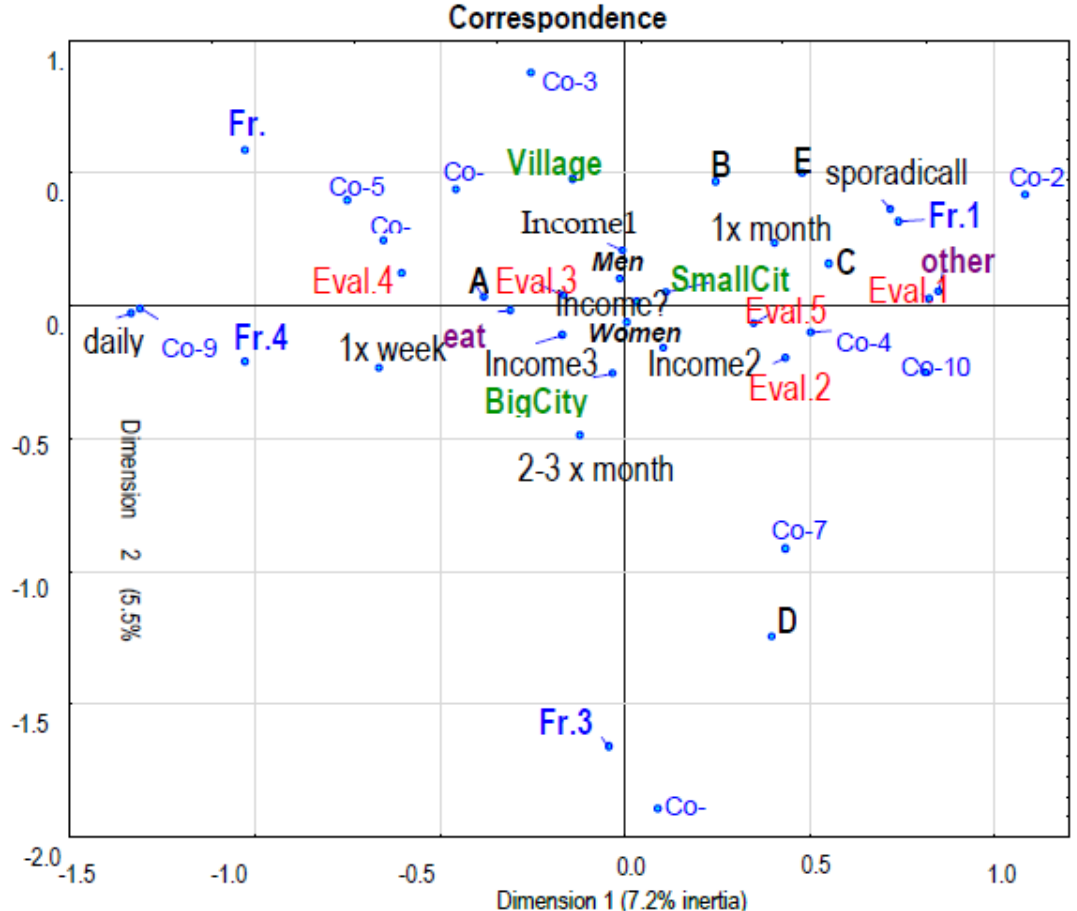
Figure 3. Correspondence graph of individual variants of respondents’ answers. University: A, B, C, D, E; Gender: Men, Women; Dwelling place: Village, Small City (City up to 100,000 inhabitants), Big City (City over 500,000 inhabitants); Financial status: Income 1—low, Income 2—average, Income 3—